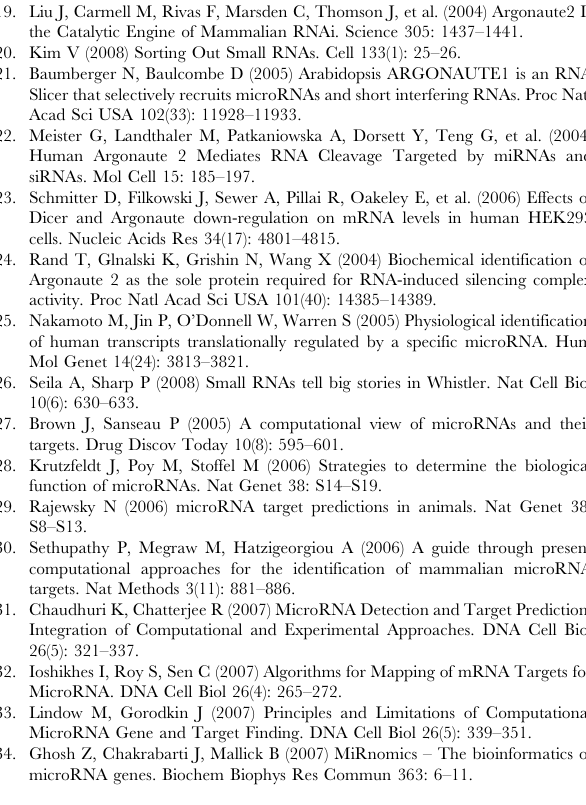
Table S1 Known m/miRNA target pairs. Table S1 contains the set of all previously observed target pairs used in this study. Alternative nomenclature for miRNAs/genes is provided. Target- ed genes are labeled (C) or (TR) depending on whether the target pair’s annotation in TarBase indicates previously observed evidence of mRNA cleavage or translational repression respec- tively. The citation provided by TarBase justifying the targeting relationship is also provided.